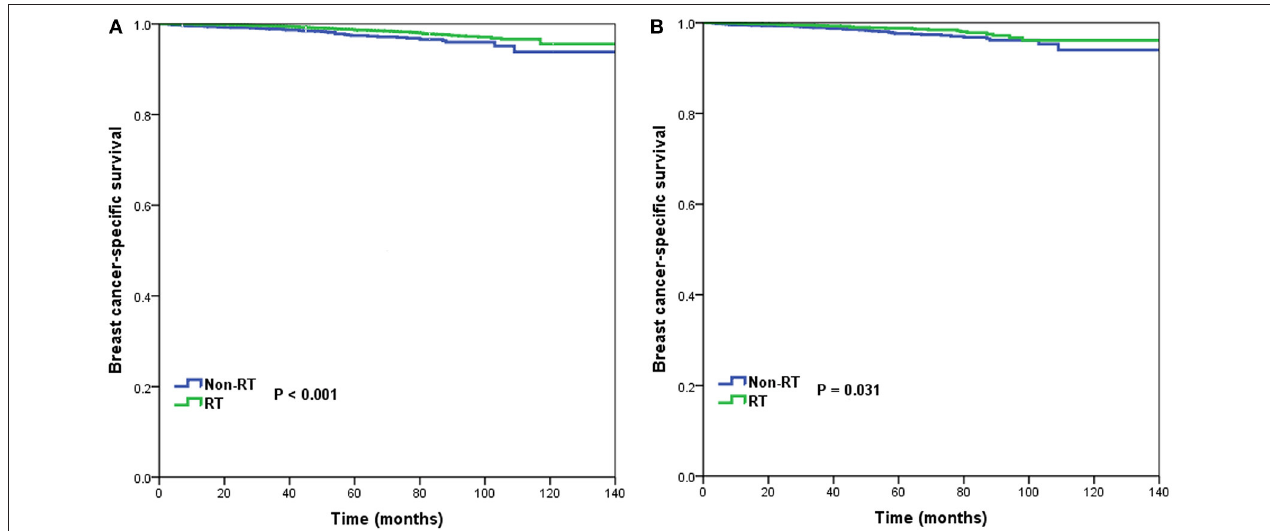
FIGURE 2 | Breast cancer-specific survival in patients who had or did not have postoperative radiotherapy in the entire cohort before (A) and after (B) propensity score matching.